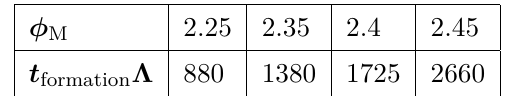
Table 4 . Formation time of the spinodal instability with varying